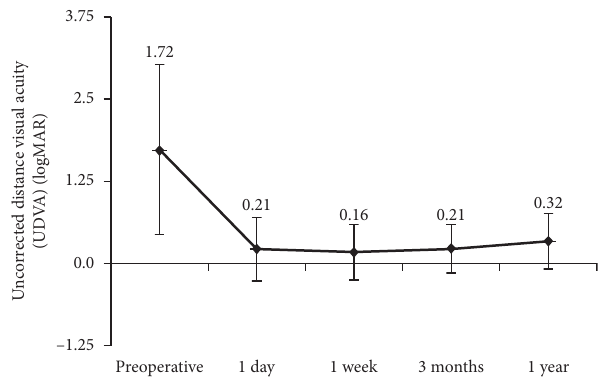
Figure 1: Preoperative and postoperative uncorrected distance visual acuity (UDVA) ( n � 144 eyes).